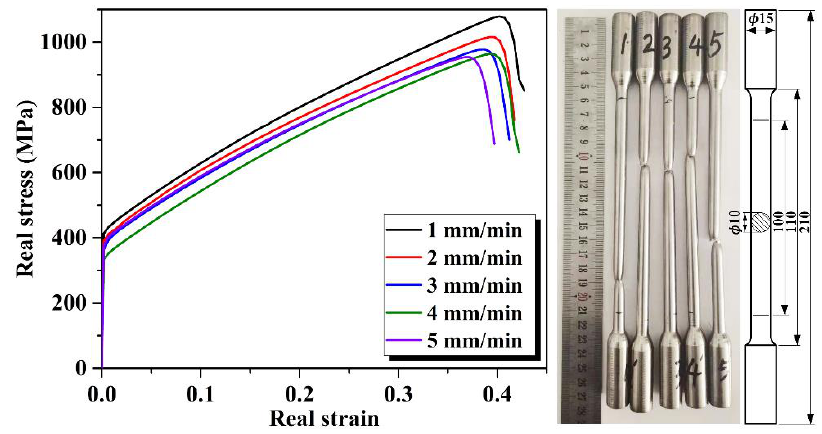
Figure 5. Stress – strain curves of tensile tests at different speeds.